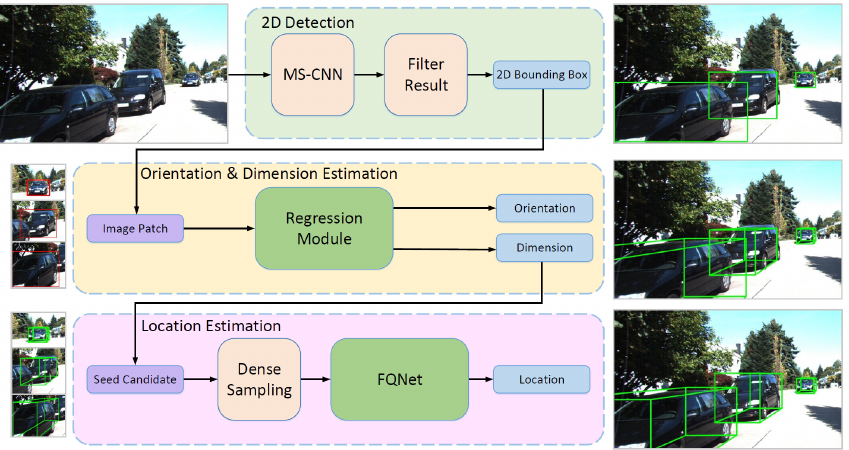
Figure 10. Overall pipeline of a deep fitting degree scoring network [74], which refines an initial bounding box using a regression module and